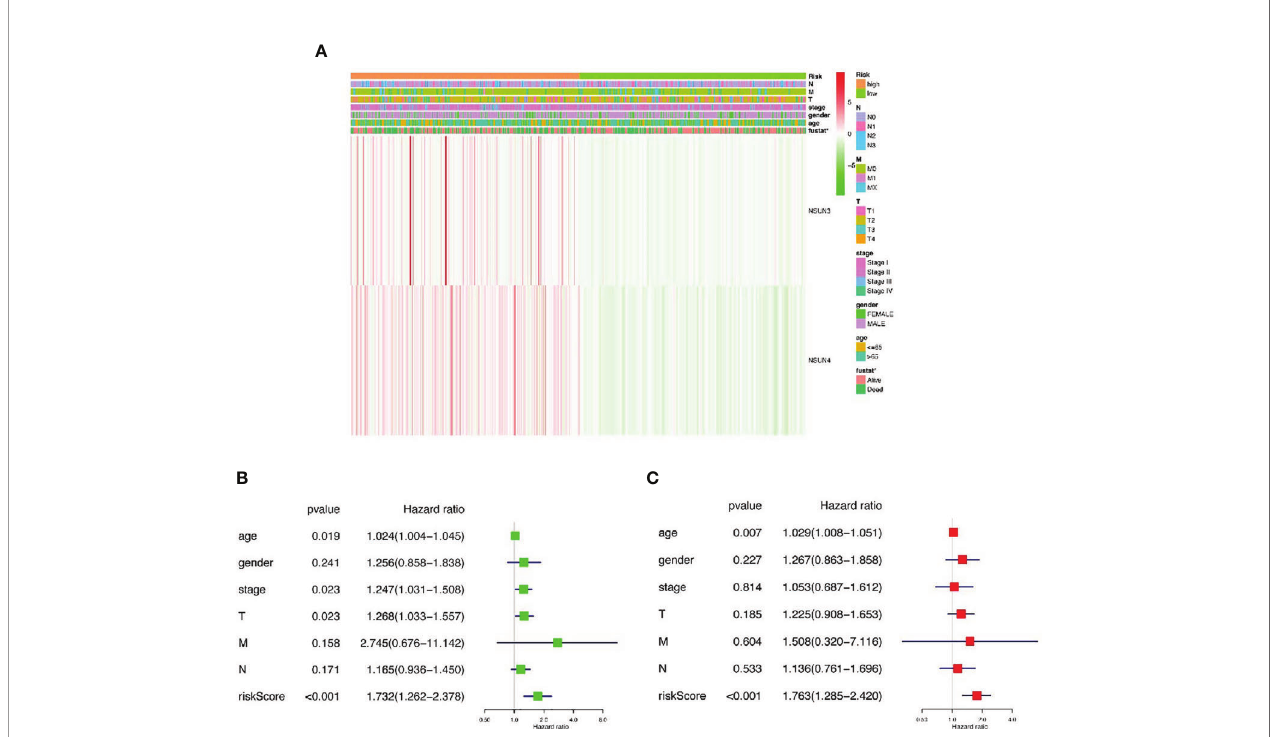
FIGURE 4 | The relationship between risk score and clinical outcome, pathological characteristics, and prognostic value of LUSC. (A) Expression differences in clinicopathological characteristics and risk scores between high and low risk groups from The Cancer genome Atlas (TCGA) dataset. (B) Univariate Cox regression analysis of clinicopathological characteristics and risk score. (C) Multivariate Cox regression analysis of clinicopathological characteristics and risk score. * p < 0.05, ** p < 0.01, *** p <